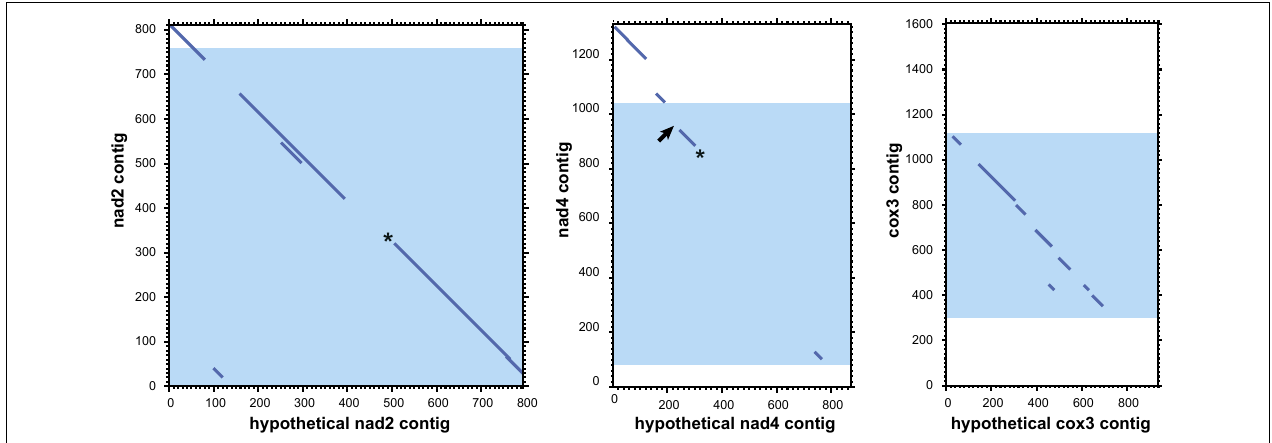
FIGURE 7 | Dotplots of local alignments of circular contigs against genes nad2 , nad4 , and cox3 . Blue zones represent mitochondrial genes with the open frame. Asterisks mark homologs with stop codons, arrows mark frameshifts. Results obtained with LAST (Kiełbasa et al., 2011) (threshold E -value for local alignment 0.008).